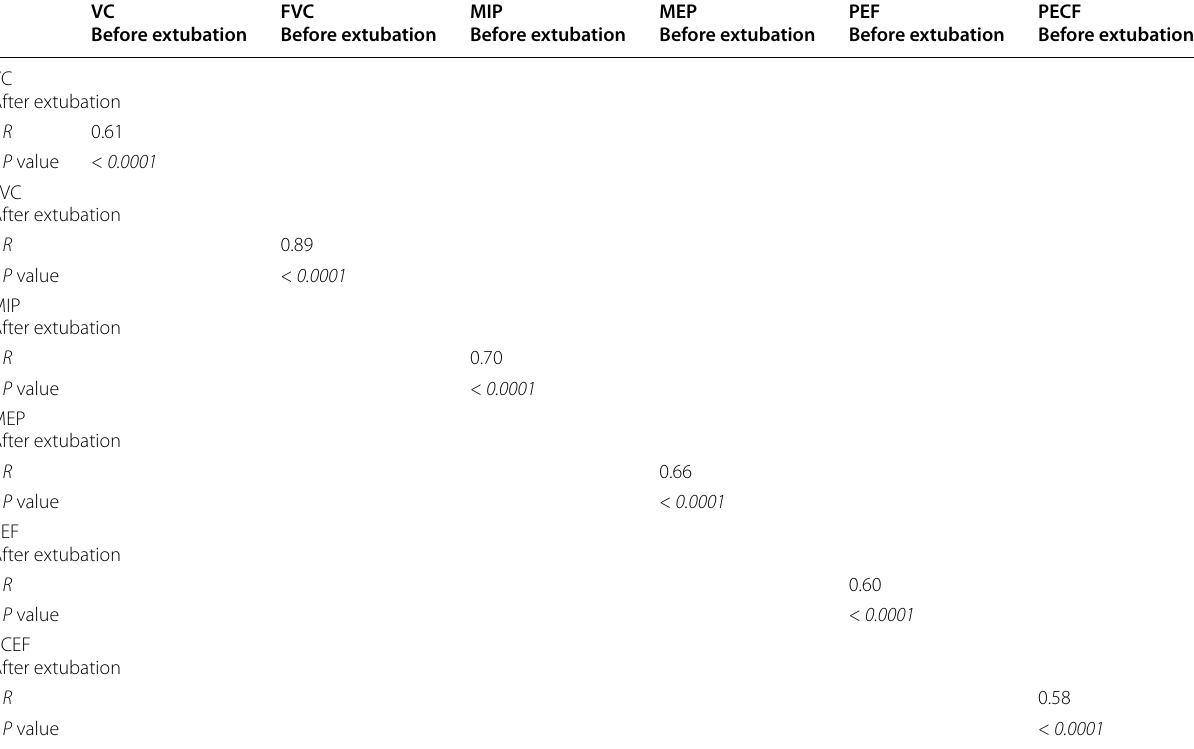
For each parameter, the table shows the correlation coefficient and P value Italics indicate significant